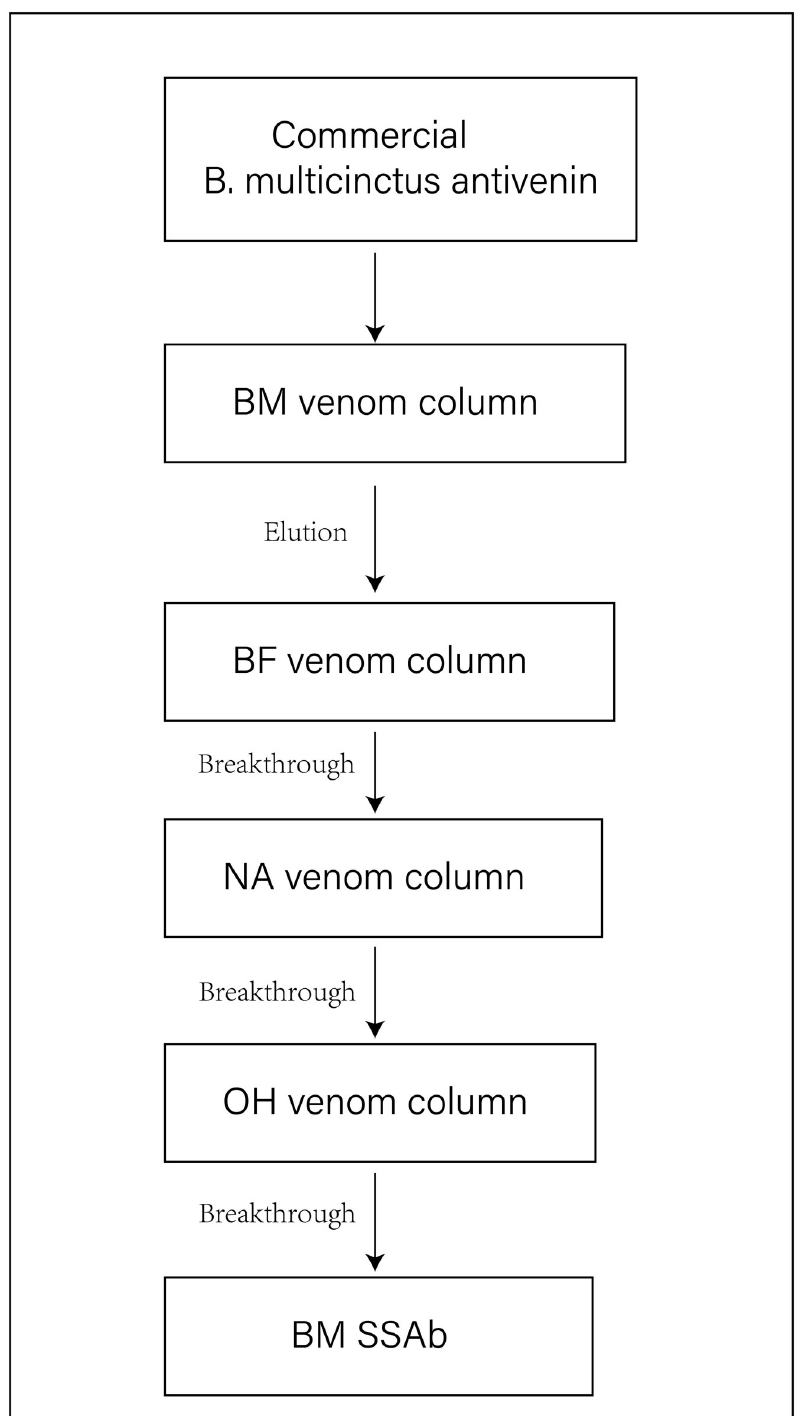
Fig 1. SSAb Preparation. Two-step immuno-affinity purification of BM SSAb: step 1, the commercial BM antivenin was absorbed by BM venom column and then eluted. Step 2, SSAb was obtained by immuno-affinity chromatography with other three heterologous venom columns to remove cross-reactivity antibody components.